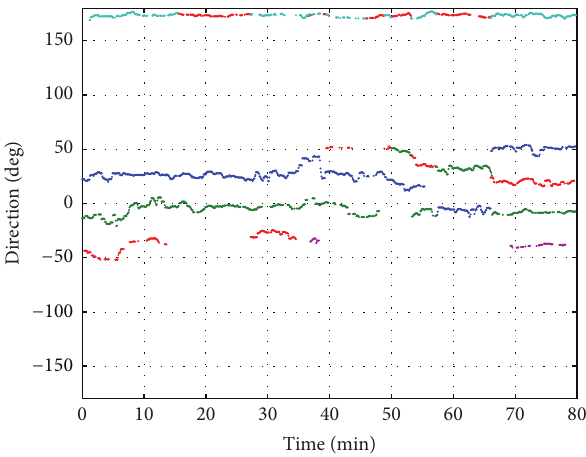
Figure 15: Visualisation of continuous audio speech tracking for a session of 1h 20 min (Dataset 2) performed using long-term spatial power density algorithm. The tracks are assigned to 4 different participants between − 50 ∘ and 50 ∘ . Additional track at 180 ∘ corresponds to remote